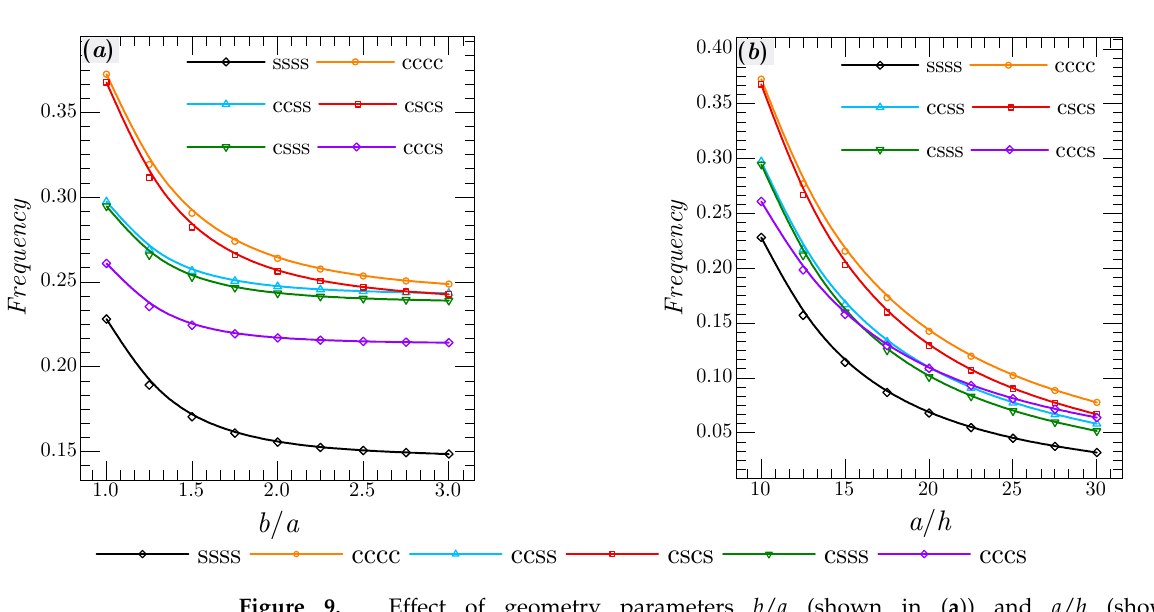
Figure 9. Effect of geometry parameters b / a (shown in ( a )) and a / h (shown in ( b )) on the dimension- less frequency of spherical shell for various boundary conditions (𝑇𝑦𝑝𝑒(𝐵), 𝐹𝐺 − 𝑋, 𝑁 = 10 𝑉 (cid:3030)(cid:3041)(cid:3047)∗ = 0.17, 𝑝 = 1 ) . To show the nonlocality effect on the dimensionless frequency of the two types of CNTRC spherical shell for various boundary conditions, Figure 10 curves are plotted.